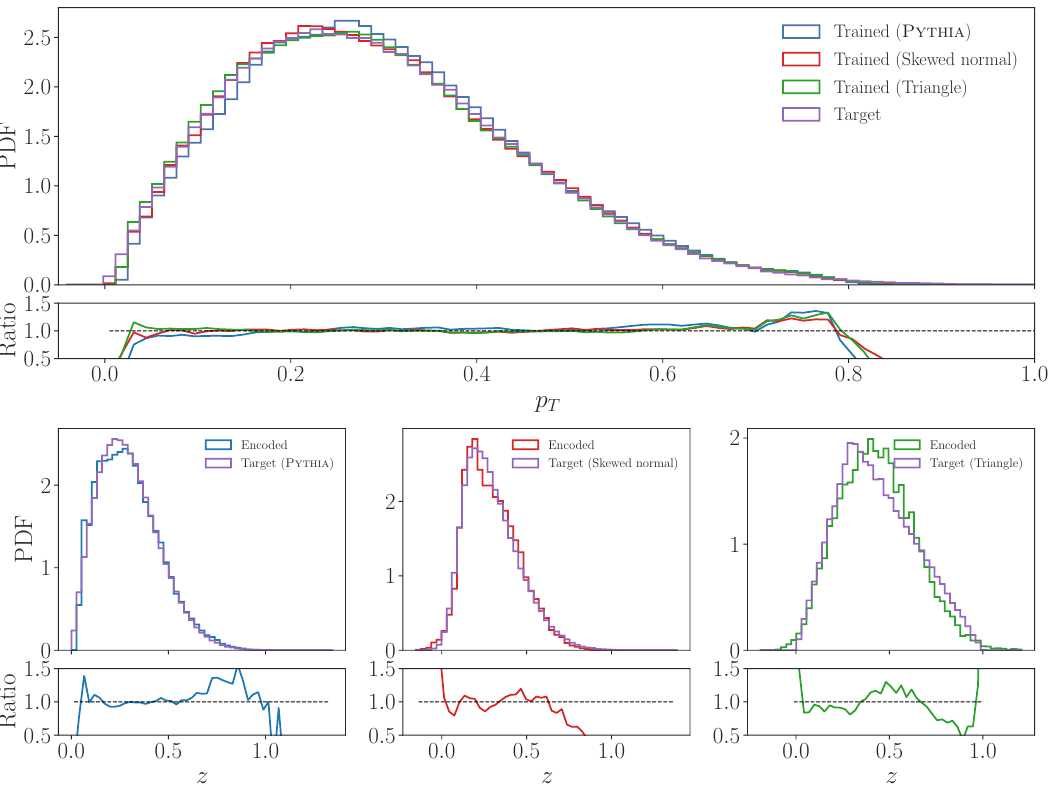
Figure 9: Top: ML HAD generated p distributions for first-hadron emission using T three different latent-space distributions, P YTHIA (blue), skewed-normal (red), and triangular (green), compared to the P YTHIA generated target distribution (purple), as well as the ratios of ML HAD generated to P YTHIA generated distributions. Bottom: comparison of the trained and target latent-space distributions for the three